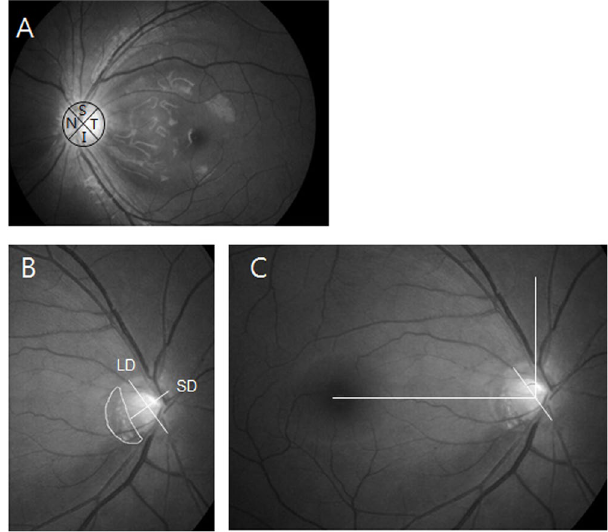
Figure 1. Demonstration of quadrant locations of split retinal nerve fiber layer (RNFL) defects and posterior pole profiles. ( A ) The location of split RNFL defects was determined by quadrant (superior, temporal, inferior, nasal, equal to 90 degrees) around the optic disc on red-free imaging. ( B ) Tilt ratio was identified as the ratio between the longest diameter (LD) and the shortest diameter (SD) of the optic disc. The β -zone parapapillary atrophy (PPA) area was calculated using the Image J program. ( C ) Torsion degree was calculated as the angle between the LD from the vertical meridian, which was at right angles to the reference line. ( A ) I, inferior; N, nasal; S, superior; T, temporal ( B ) LD, longest diameter; SD; shortest